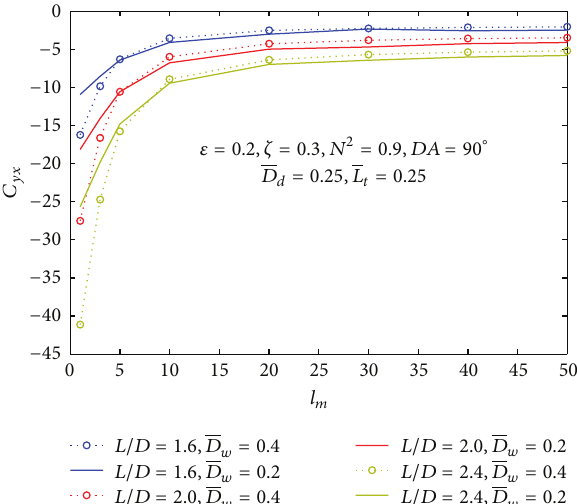
Figure 11: Variation of C 𝑦𝑥 as a function of characteristics length “ l m